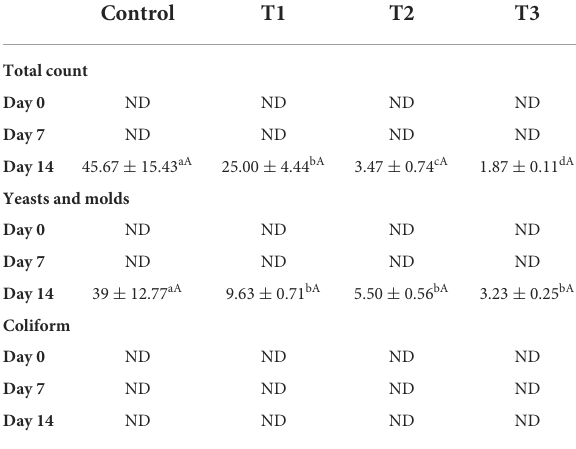
TABLE 4 Microbial growth of whey/strawberry beverage enriched with different concentrations of beetroot peel water extract during storage